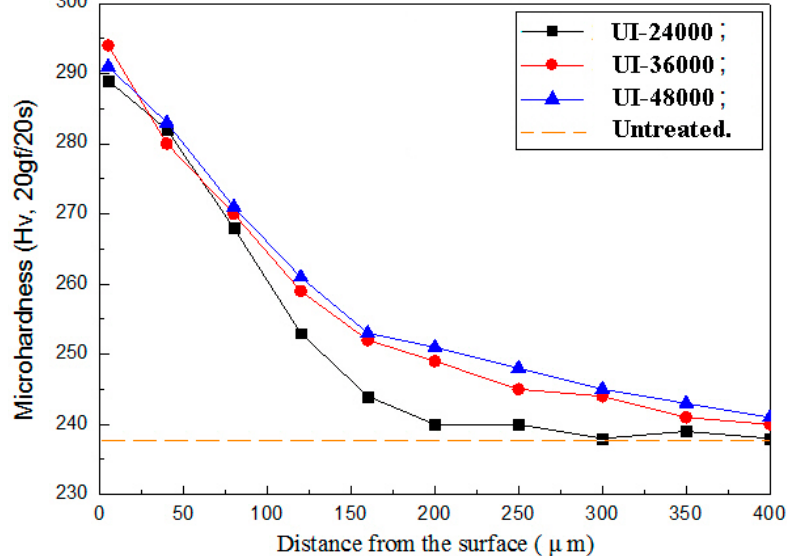
Figure 5. Distribution of surface hardness with ultrasonic surface impact.